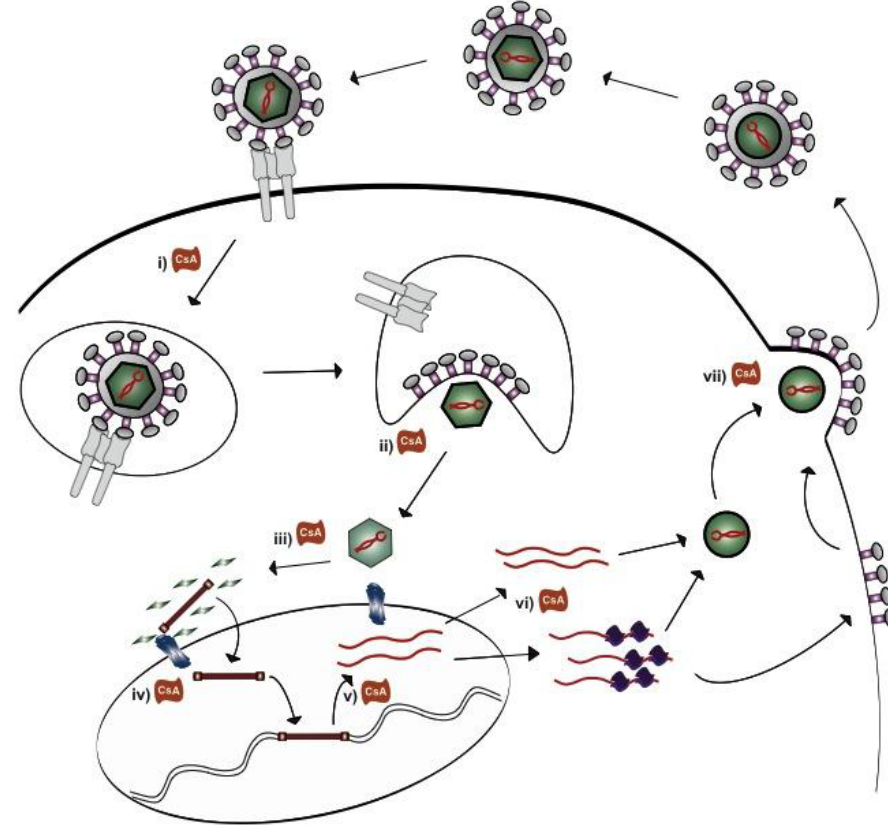
Figure 3. Cyclophillin inhibitors may block the betaretrovirus life cycle at distinct steps. The early events of retroviral infection include ( i ) internalization following receptor engagement, ( ii ) disassembly and ( iii ) uncoating during reverse transcription, ( iv ) nuclear import of the preintegration complex and proviral integration. In the MMTV producing Mm5MT cells, antiviral blockade with cyclophilins can impact on the more